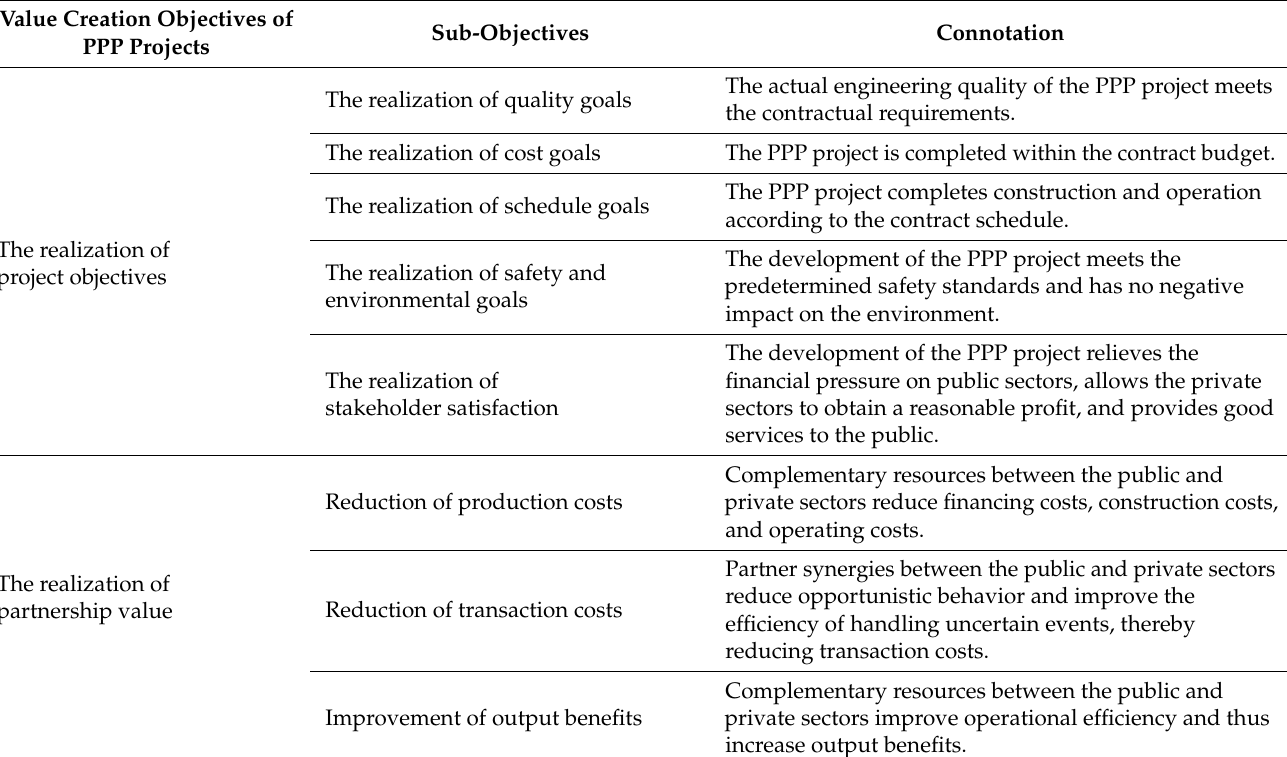
Table 1. The value creation objectives of PPP